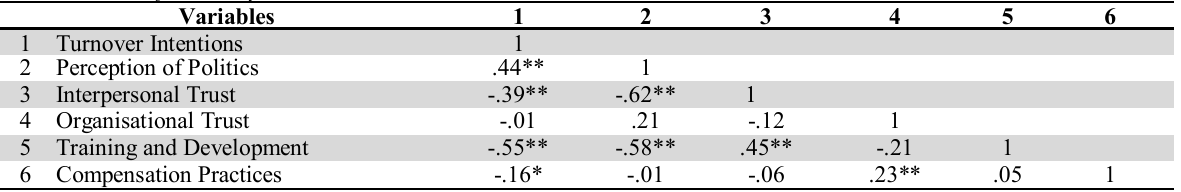
Correlations for Study Variables